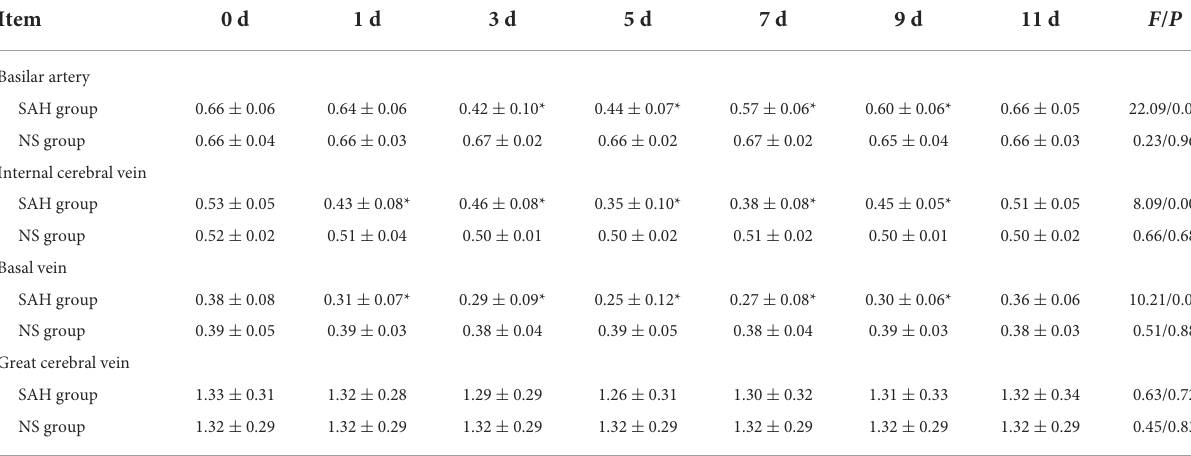
TABLE 1 The diameter of the basilar artery and deep cerebral